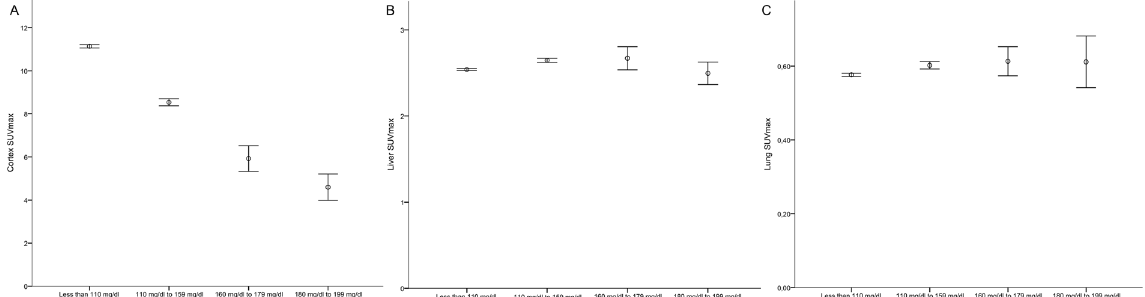
Figure 1. SUVmax values (95% confidence intervals) stratified by glucose range in the cortex, liver, and lung. ( A ) Cortical SUVmax in the population according to glycemic range, showing significant differences among all categories. However, such difference was not observed between SUVs of the liver ( B ) and lung ( C ) and the blood glucose level ranges.